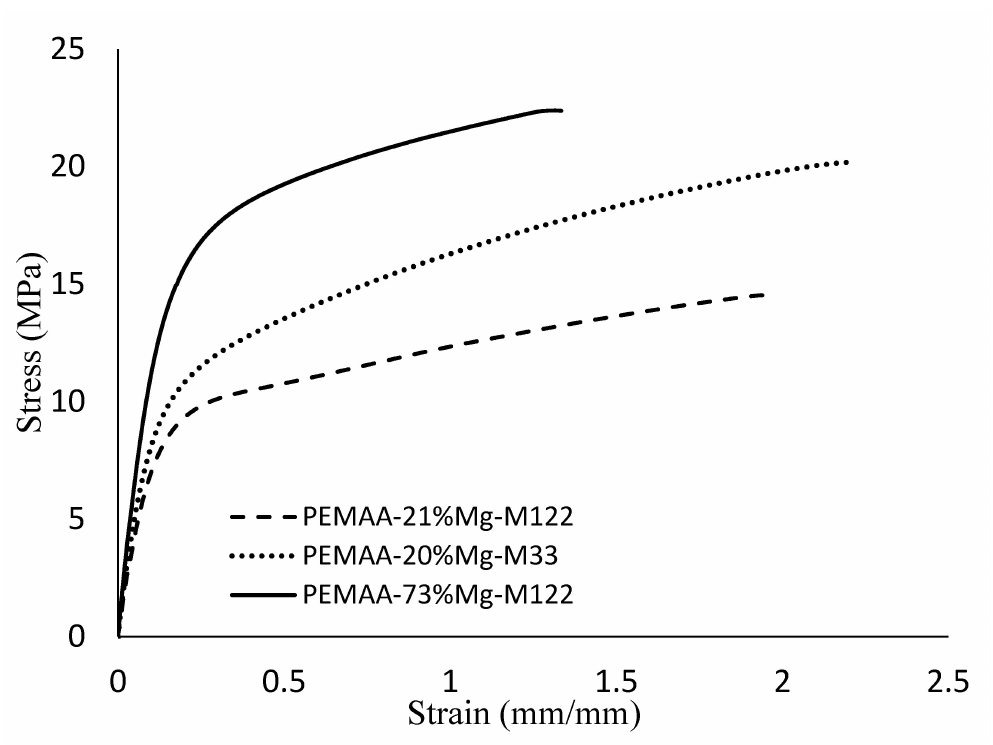
Figure 10. Representative graph of tensile stress vs. tensile strain for PEMAA-73%Mg-M122 and